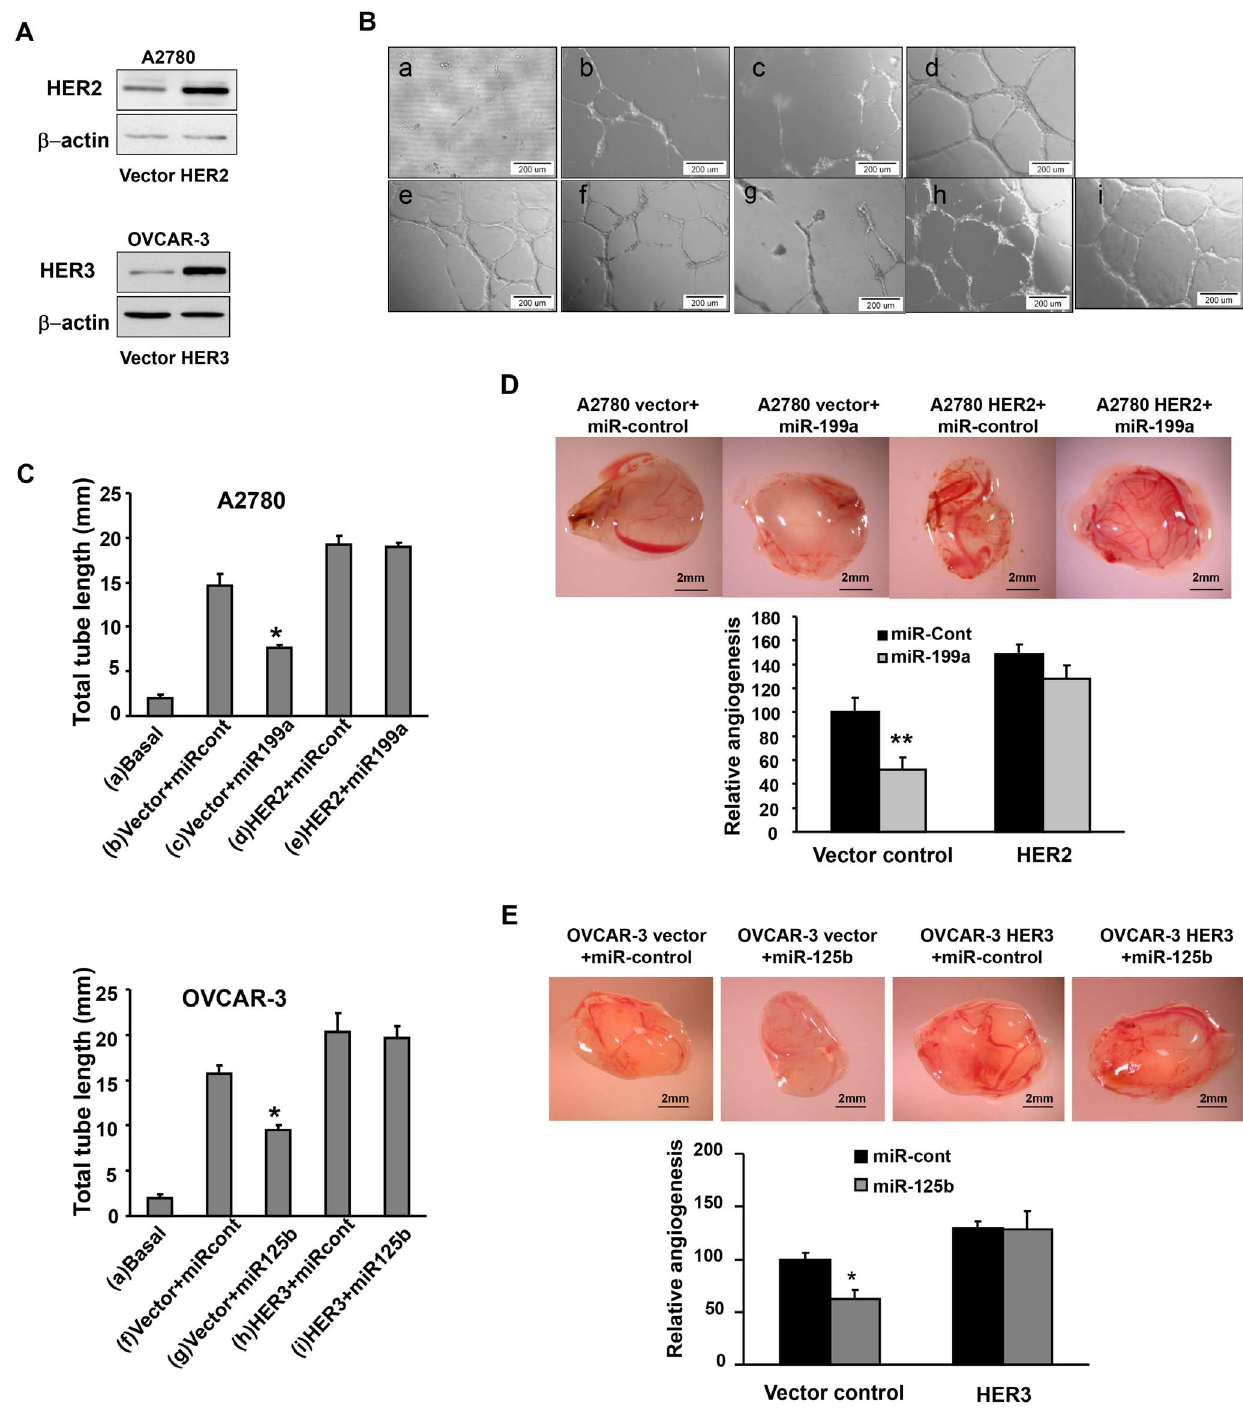
Figure 4. Overexpression of HER2 and HER3 reverses miR-199a- and miR-125b-inhibited tumor angiogenesis. (A) Immunoblotting to confirm establishment of an A2780 cell line stably overexpressing HRE2 and OVCAR-3 cell line stably overexpressing HER3 using pBABEpuro and pReceiver-Lv105 vector, respectively. (B) Tube formation assay using HUVEC cells was described as in Figure 2. (C) Total tube lengths for each treatment were analyzed and presented as mean 6 SE (millimeter) from six replicates for each treatment. *Significantly different vs vector + miR- control (P , 0.05). (D, E) A2780 and OVCAR cells were transfected pre-miR-control, pre-miR-199a or pre-miR-125b, respectively; and implanted onto the CAMs to perform angiogenesis assay as in Figure 2. The representative images from each group were shown here. The total number of blood vessels in each group was quantified. *,**Significantly different compared with that of the same cell line transfected with pre-miR-control with *P , 0.05 and **P , 0.01.